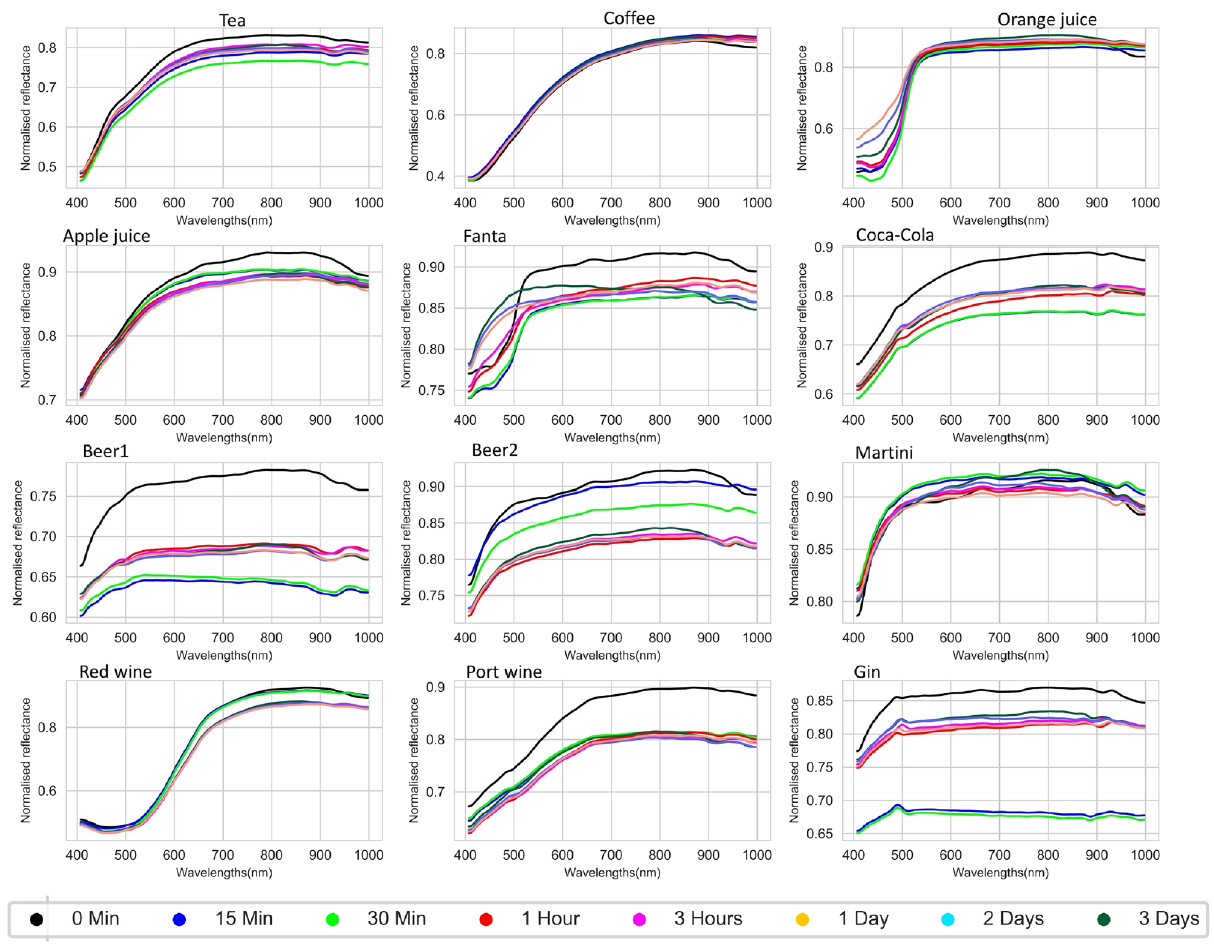
Figure 11. Spectra of 12 beverage stains over time